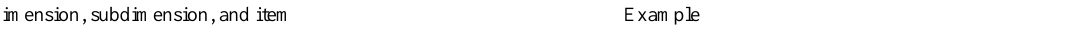
Table 1. Evaluation framework for the quality of social media suicide